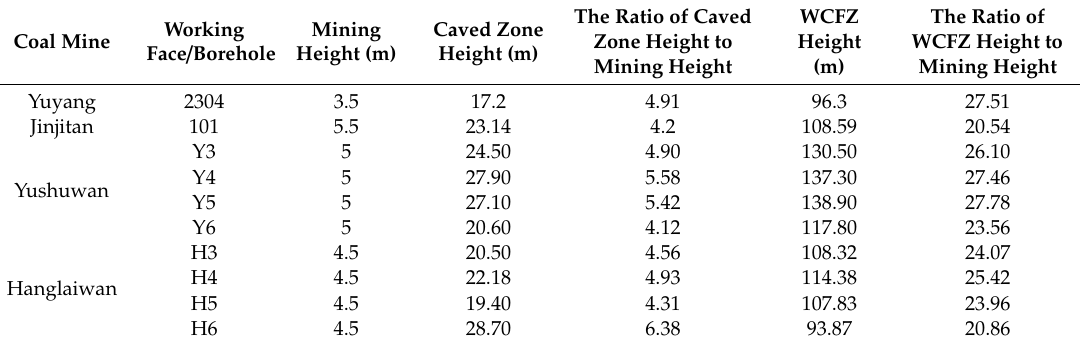
Figure 10. The three zones in overlying strata and groundwater inrush resulting from longwall mining.